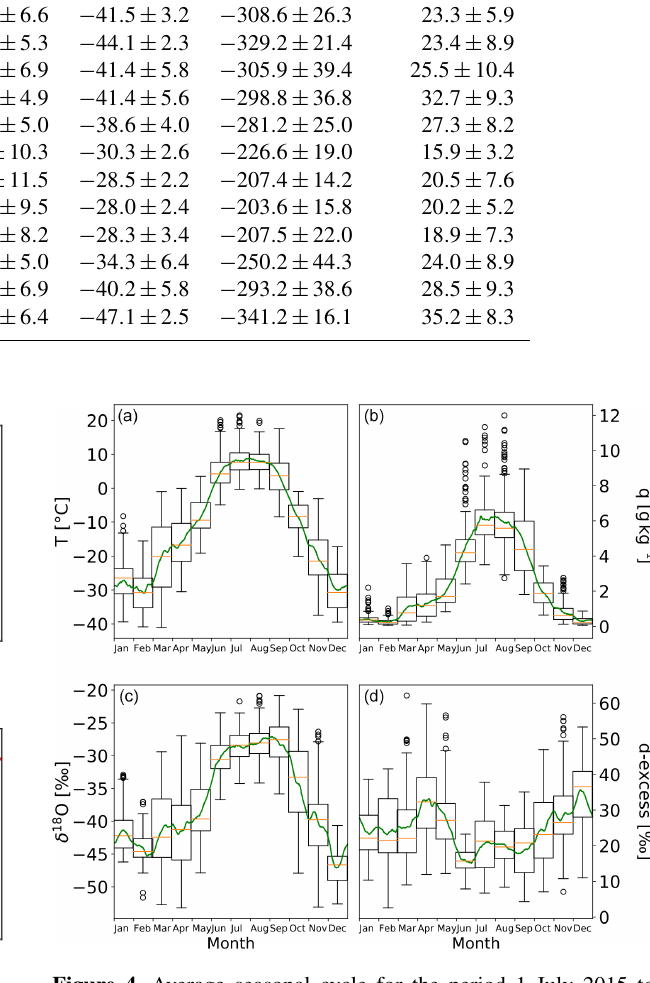
Figure 3. Co-variations of water vapour isotopic composition and meteorological parameters for the complete period 1 July 2015 to 1 July 2017. Red lines represent the best estimate of the linear re- gression. (a) δ 2 H v (‰) as a function of δ 18 O v (‰); (b) specific hu- midity q (gkg − 1 ) as a function of air temperature ( ◦ C); (c) δ 18 O v (‰) as a function of air temperature ( ◦ C); (d) δ 18 O v (‰) as a func- tion of specific humidity (gkg − 1 ).